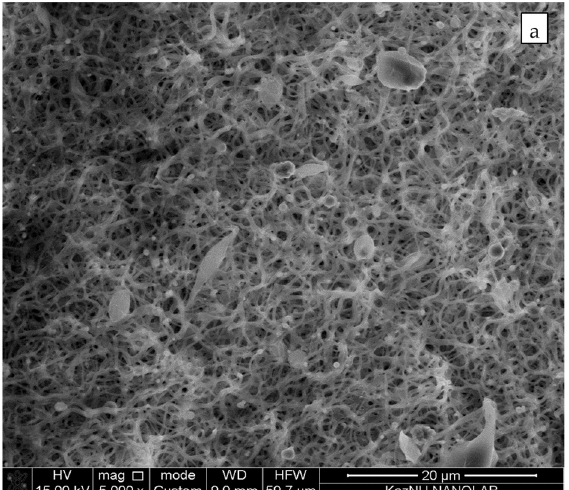
Figure 2. Results of characterization: ( a ) SEM in SE mode image of intermediate PAN/NiO fibers after stabilization at 260 °C, ( b ) SEM in SE mode image of NiO/C fibers from PAN/NiO after stabilization at 260 °C and carbonization at 700 °C; ( c ) EDAX spectrum of NiO/C fibers after carbonization and ( d ) NiO/C fiber diameter distribution after carbonization. 3.3. Gas Sensitive Characteristics of NiO/C Composite Fibers The electrical response of the gas sensitive material to volatile organic compounds (acetylene and acetone) was tested. When exposed to acetone and acetylene, a change in resistivity is clearly observed, which is due to the sensitivity of the material to these gases. Figure 3a,b shows graphs of the conductivity of NiO/C fibers as a function of time.